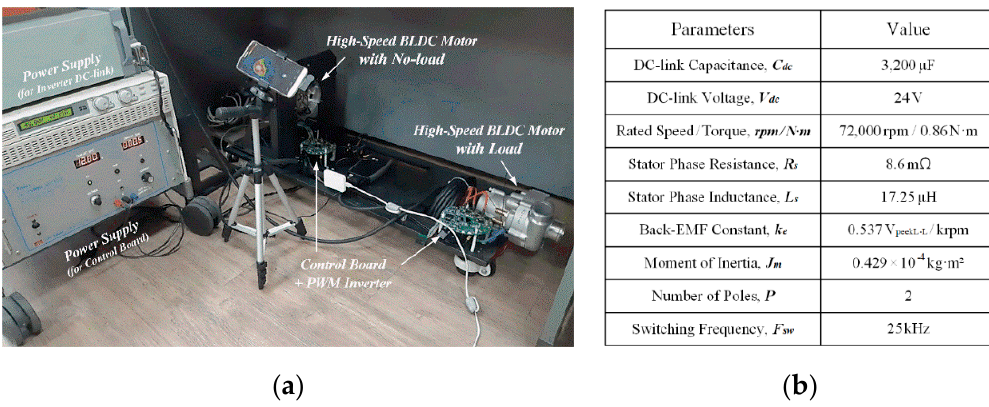
Figure 6. Experimental high-speed BLDC motor drive system: ( a ) experimental setup; ( b ) electrical parameters.